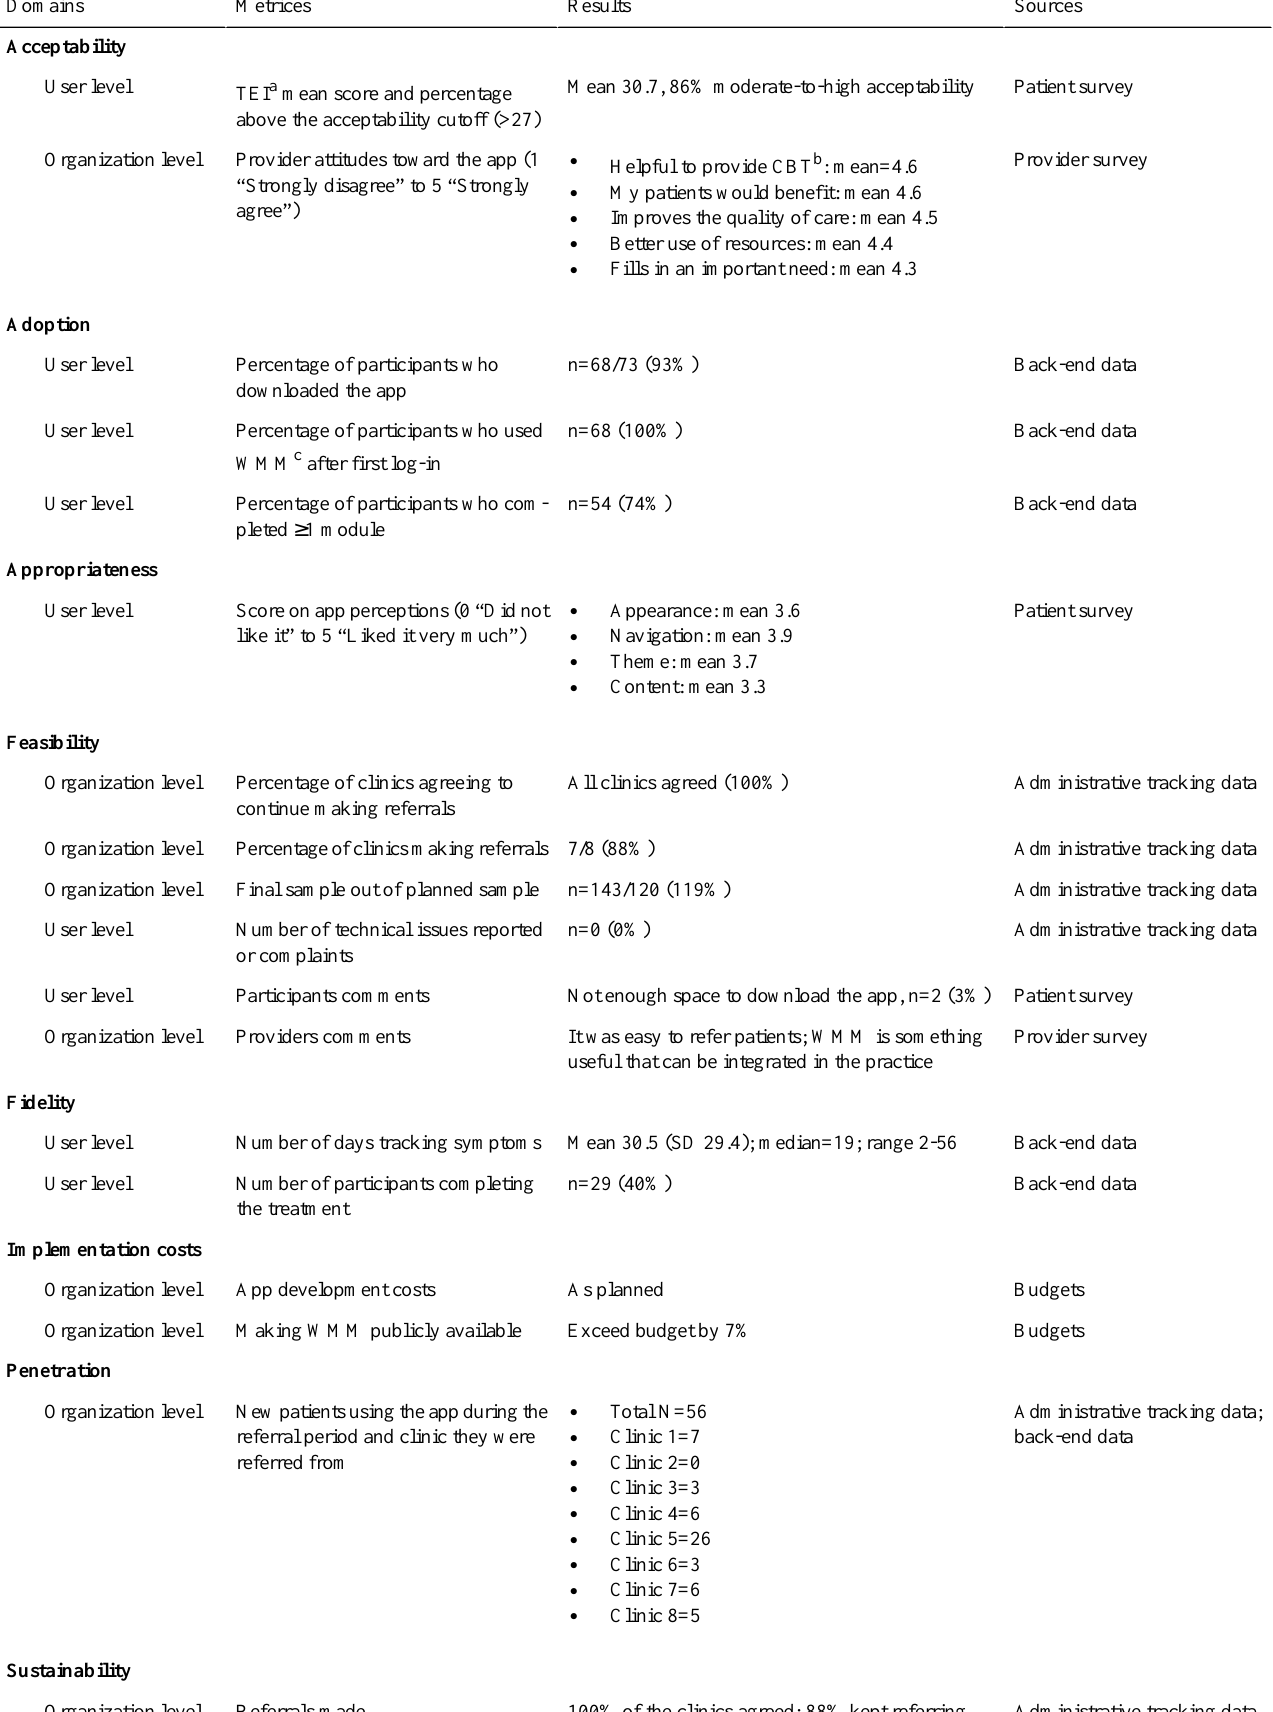
Table 2. Summary of implementation using the Behavior Interventions using Technology